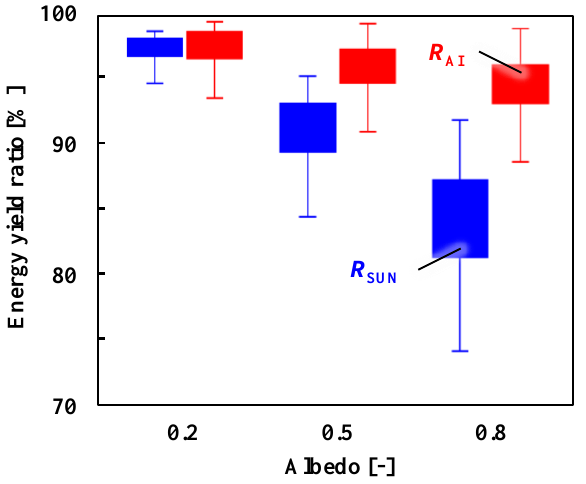
Figure 7. Box plot of daily energy-yield ratio in 5-year simulation (RUNs 1 – 10).